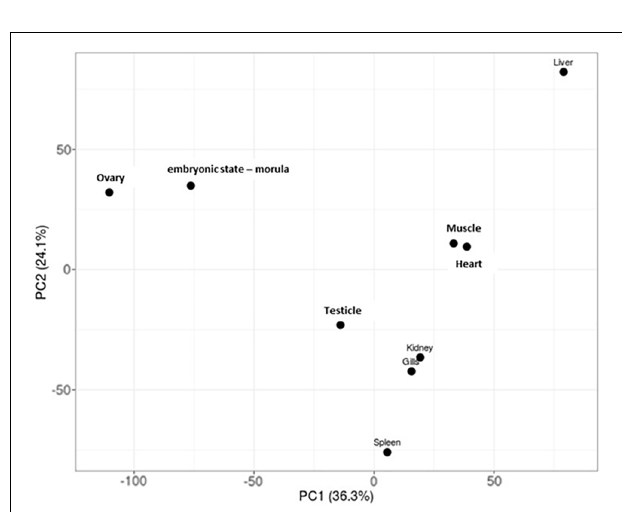
FIGURE 3 | PCA plots of log2-normalized FPKM of eight tissue and an embryonic state – morula – of Patagonian toothfish